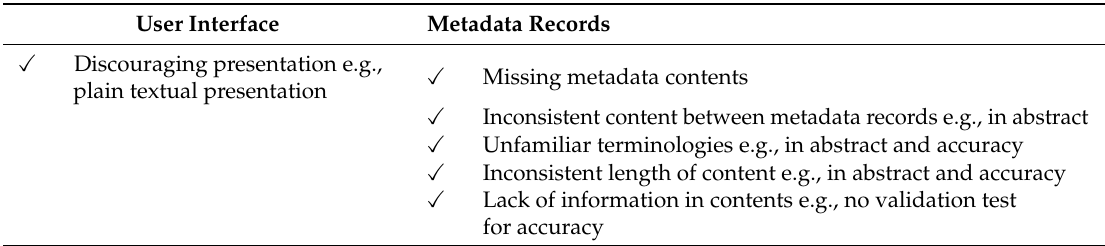
Table 8. Identified usability problems in spatial data